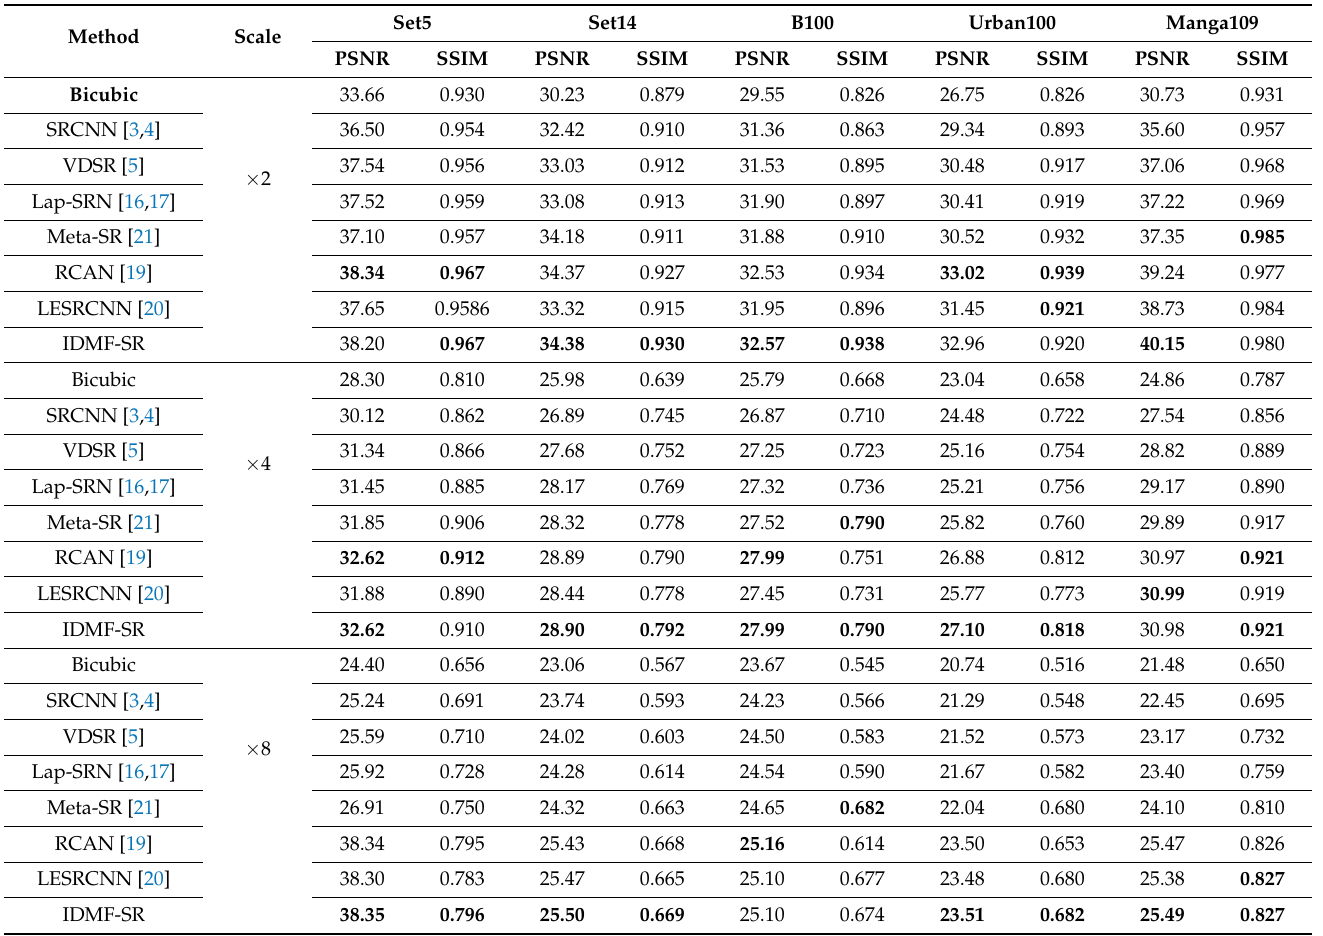
Table 3. Average PSNR and SSIM values of different methods under × 2, × 4, and × 8 on datasets Set5, Set14, BSD100, Urban100, and